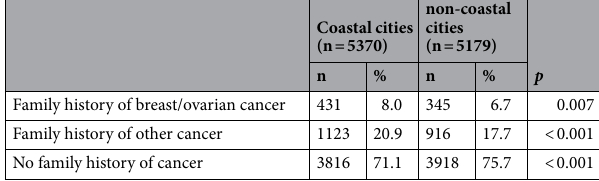
Table 2. Regional effects on family history of breast